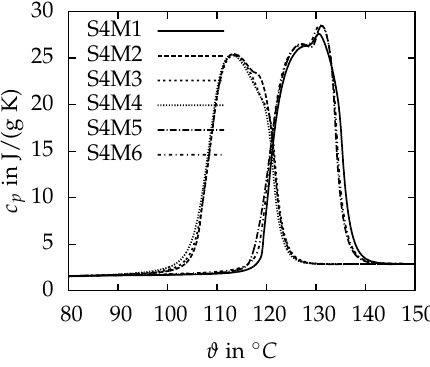
Figure 5: Heat capacity of erythritol at different melting cycles. Figure 4. Heat capacity of erythritol at different melting cycles. The sample has two different melting points depending on the present crystal structure within the solid phase.